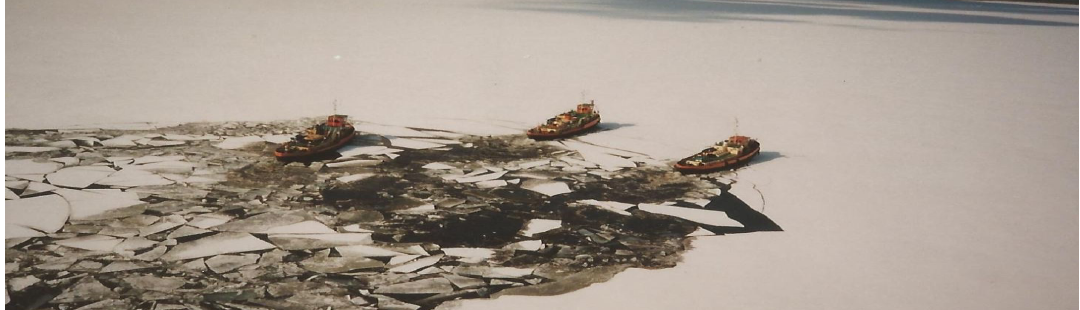
Figure 4. Ice breakers operating in parallel to break up thinner ice covers on low sloping waters (courtesy of Regional Water Management Authority, Szczecin).